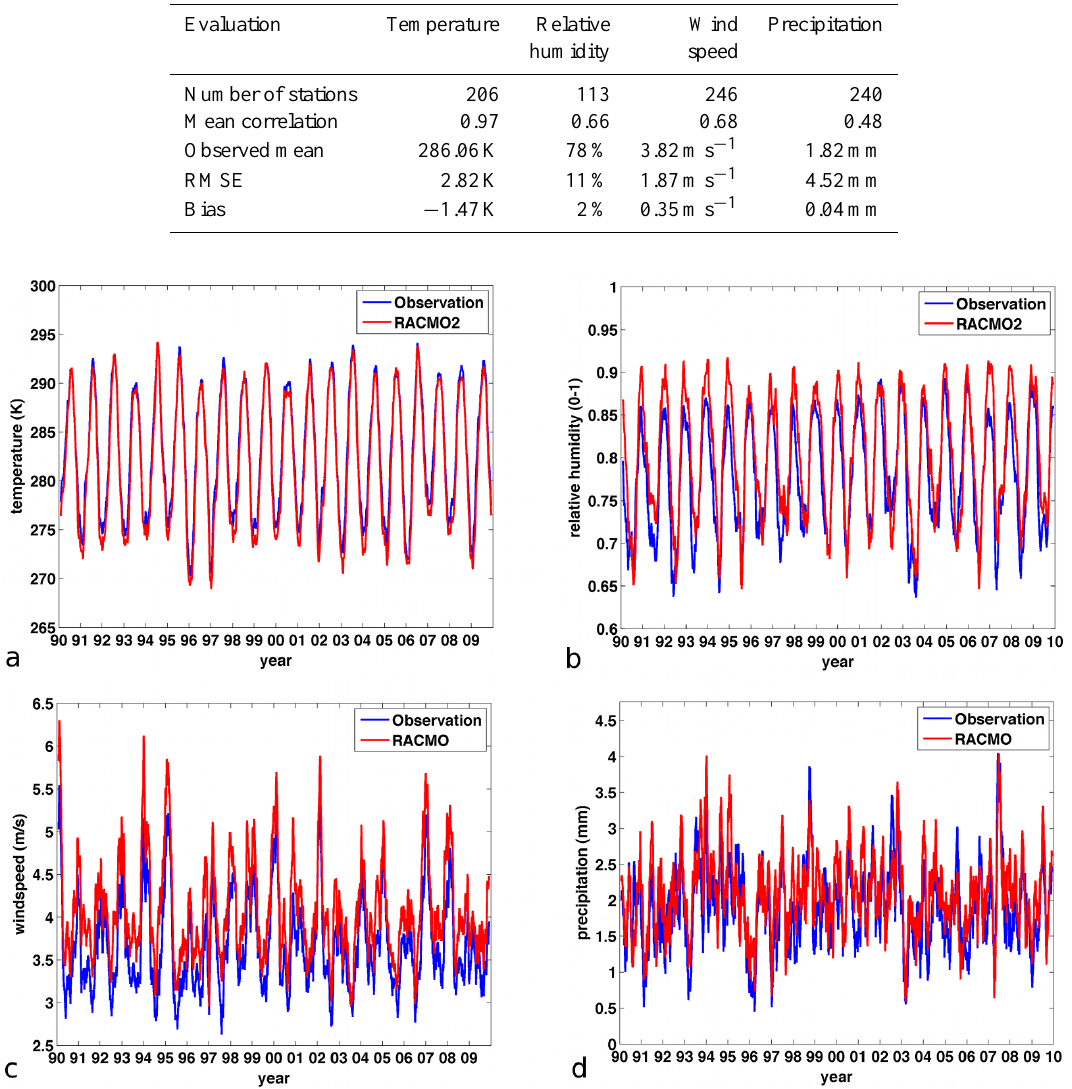
Table 2. Statistical comparison between measured and modelled meteorological parameters using daily observations at European observa- tional sites. The number of considered stations, mean correlation, observed mean, RMSE and bias are given.